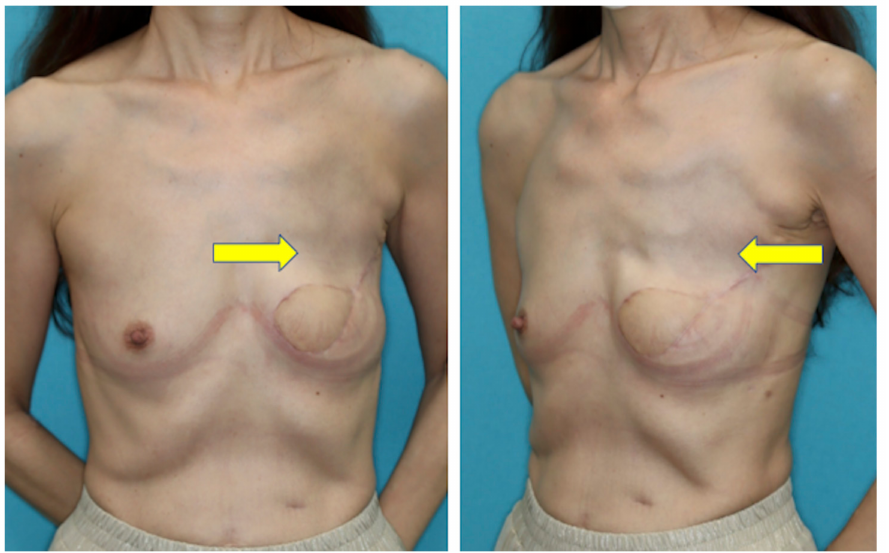
Figure 7. Lack of volume in the upper pole apparent at the 12 months follow-up after breast reconstruction with a conventional PAP flap (yellow